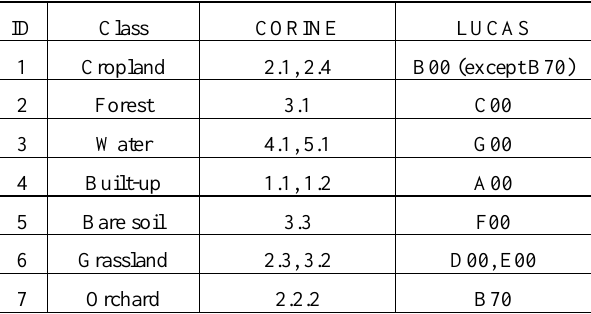
Table 1. Overview of the land-cover classes used in this research, including CORINE Level 2/3 and